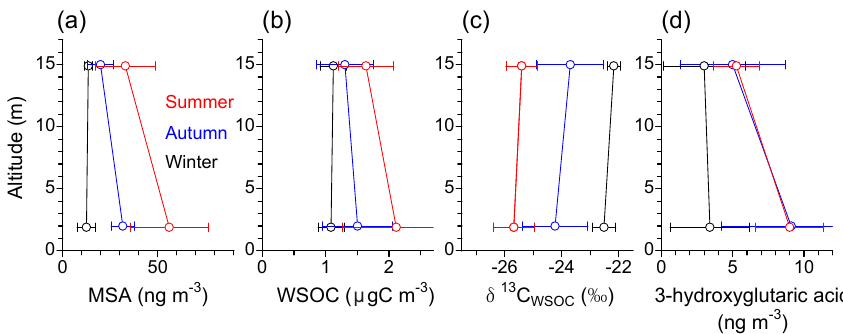
Fig. 5. Vertical profiles of (a) MSA, (b) WSOC, (c) δ 13 C WSOC , and (d) 3-hydroxyglutaric acid (HGA) in summer (June–August 2010), autumn (September–November 2010), and winter (December 2010) at the study site. Values shown are averages with standard deviations at two heights. Note that the vertical profiles are not necessarily